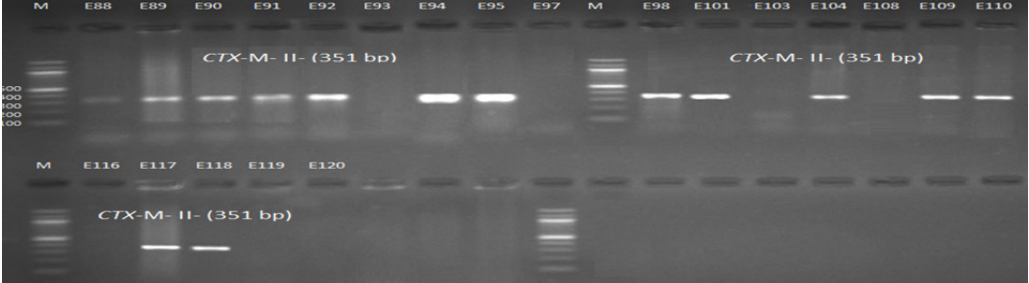
Fig. 5. 1.5% Agarose gel electrophoresis at 72 volt for 90 minutes of PCR to blaCTX-M-II amplicon (351bp); lane M represent DNA marker size(100bp) while E88-E120 represent the isolates